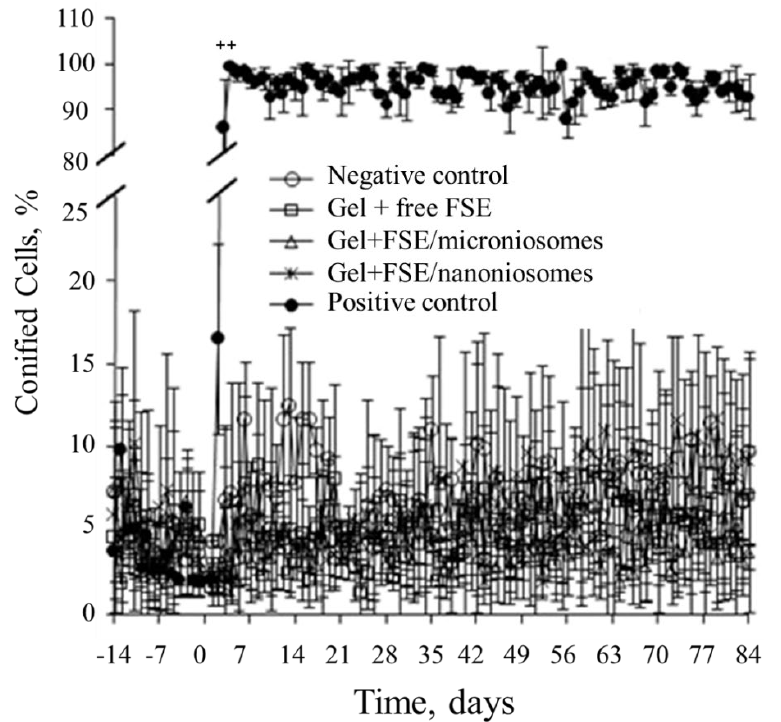
Figure 5. Percentage of vaginal cornified cells in rats treated with FSE for 84 days. p < 0.001 compared to negative control. Values are expressed as mean ± SD ( n = 4 – 5 ).